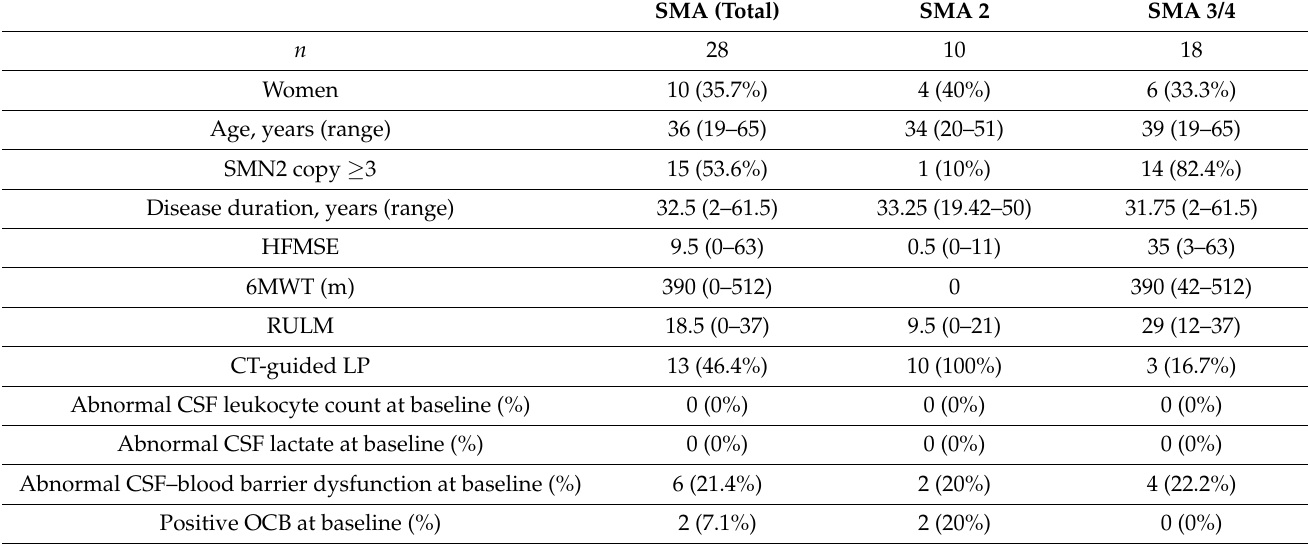
Table 1. Demographic characteristics of SMA patient groups. Age, disease duration until therapy start, HFMSE, 6MWT, and RULM are described as median with range. Above-listed values for the HFMSE, 6MWT, and RULM were collected at baseline (d0). The SMN2 copy number was not available in one 58-year-old SMA type 3 male patient. 6MWT: 6-minute walk test; CNS: central nervous system; CT: computed tomography; HFMSE: Hammersmith Functional Motor Scale Expanded; LP: lumbar puncture; OCB: oligoclonal bands; RULM: Revised Upper Limb Module; SMA: spinal muscular atrophy; SMN 2 gene: survival motor neuron 2